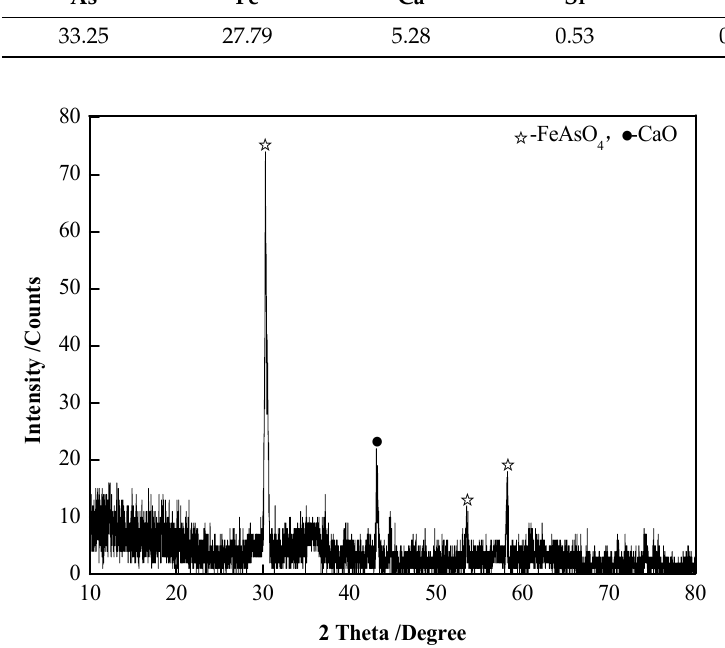
Figure 2. Mineral phase distribution of the arsenic–iron precipitate analyzed by EPMA. 2.2. Experimental Device and Methods Experimental device: The experimental device was a vertical tubular atmosphere fur- nace, as shown in Figure 3, with a size of Ф 20 mm × 150 mm. A silicon carbide rod was used for heating; the highest heating temperature was 1000 °C, and the temperature con- trol accuracy was ±2 °C. In the kinetic experiments, a quartz crucible was hung on the analytical balance.